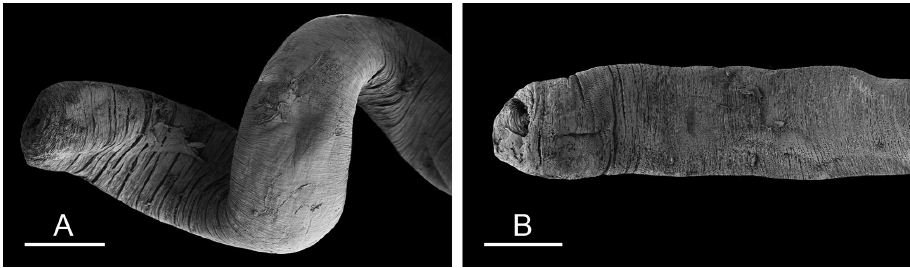
Figure 33. Penis, Wallaconchis nangkauriense , Philippines. A Luzon, scale bar 200 μm [3208] (PNM 041205) B Bohol, scale bar 200 μm [3268] (PNM